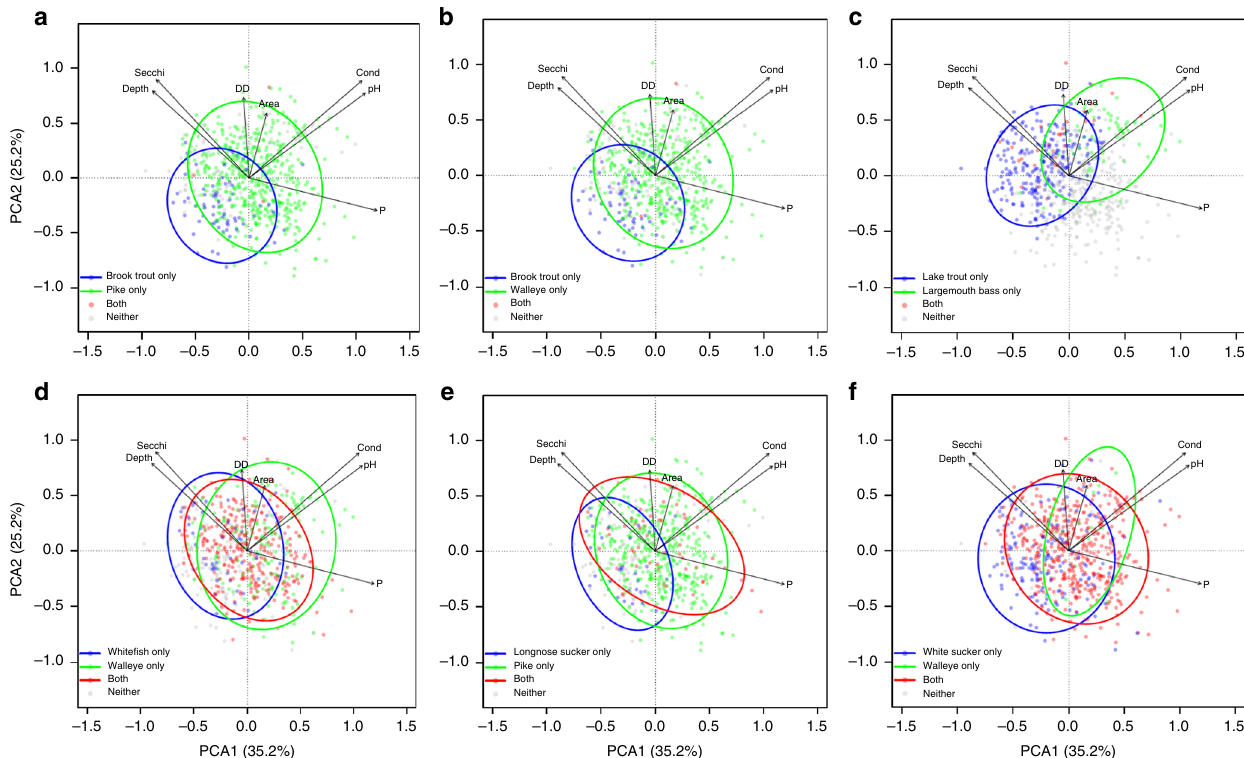
Fig. 2 Categories of habitat overlap among fi sh species. Representative ordinations of lakes in multivariate environmental space for fi sh species pairs, divided into four broad categories described in Supplementary Table 4: a – c species rarely co-occur — there can be a large overlap between A alone and B alone (i.e., they can tolerate similar lake conditions), yet they are rarely found together — this is consistent with negative interactions; d at least one species inhabits a compressed range of lake conditions when the other is present — this could be due to abiotic limitations of one or both species, such that the range of conditions inhabitable is narrower than when they are alone, or it could result from ‘ contingent coexistence, ’ where a subordinate can only escape the effects of a dominant in certain environmental conditions; e species co-occur quite often with no evidence of a narrowing of environmental conditions in the presence of the other; and f one species is found in a greater range of environmental conditions when the other is present. DD = degree days; P